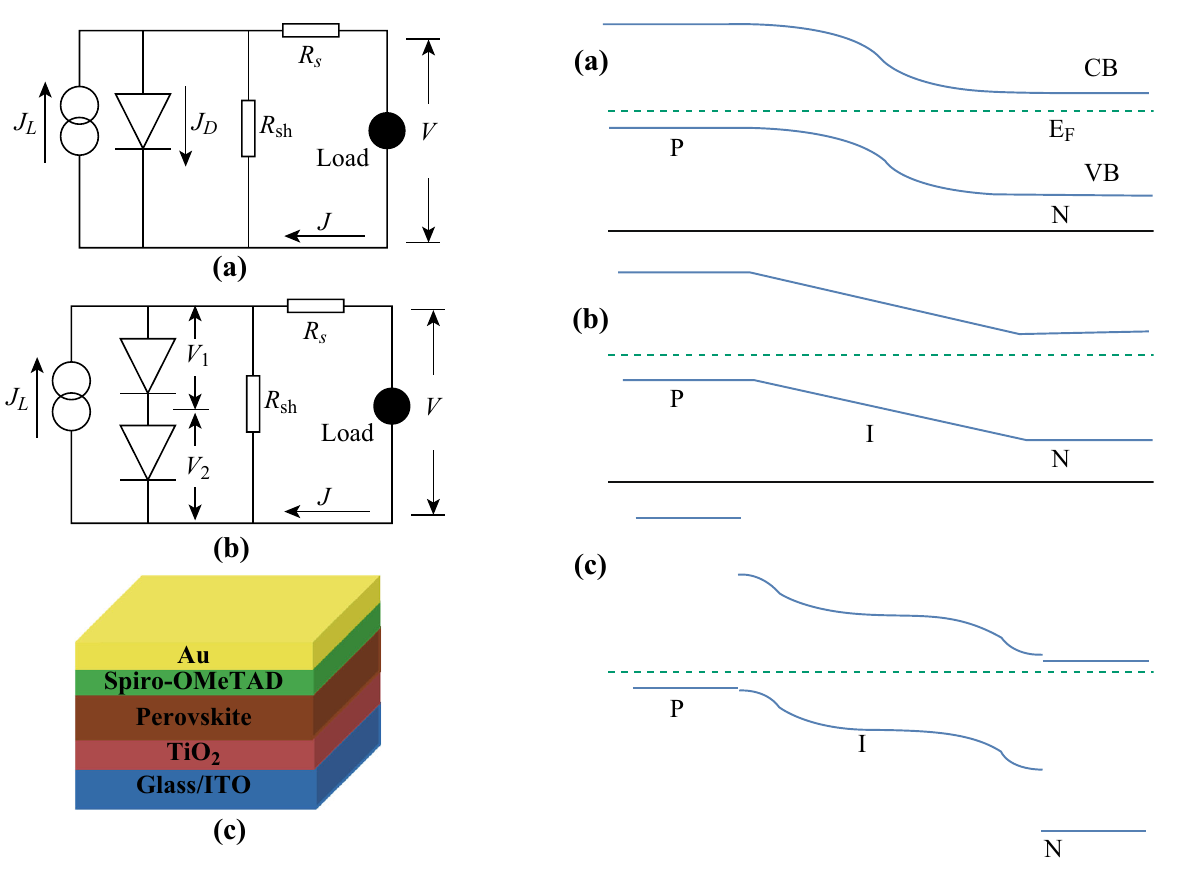
Fig. 2 Energy band diagram of different PN junction photovoltaic devices. a A PN junction solar cell. b A P–I–N solar cell